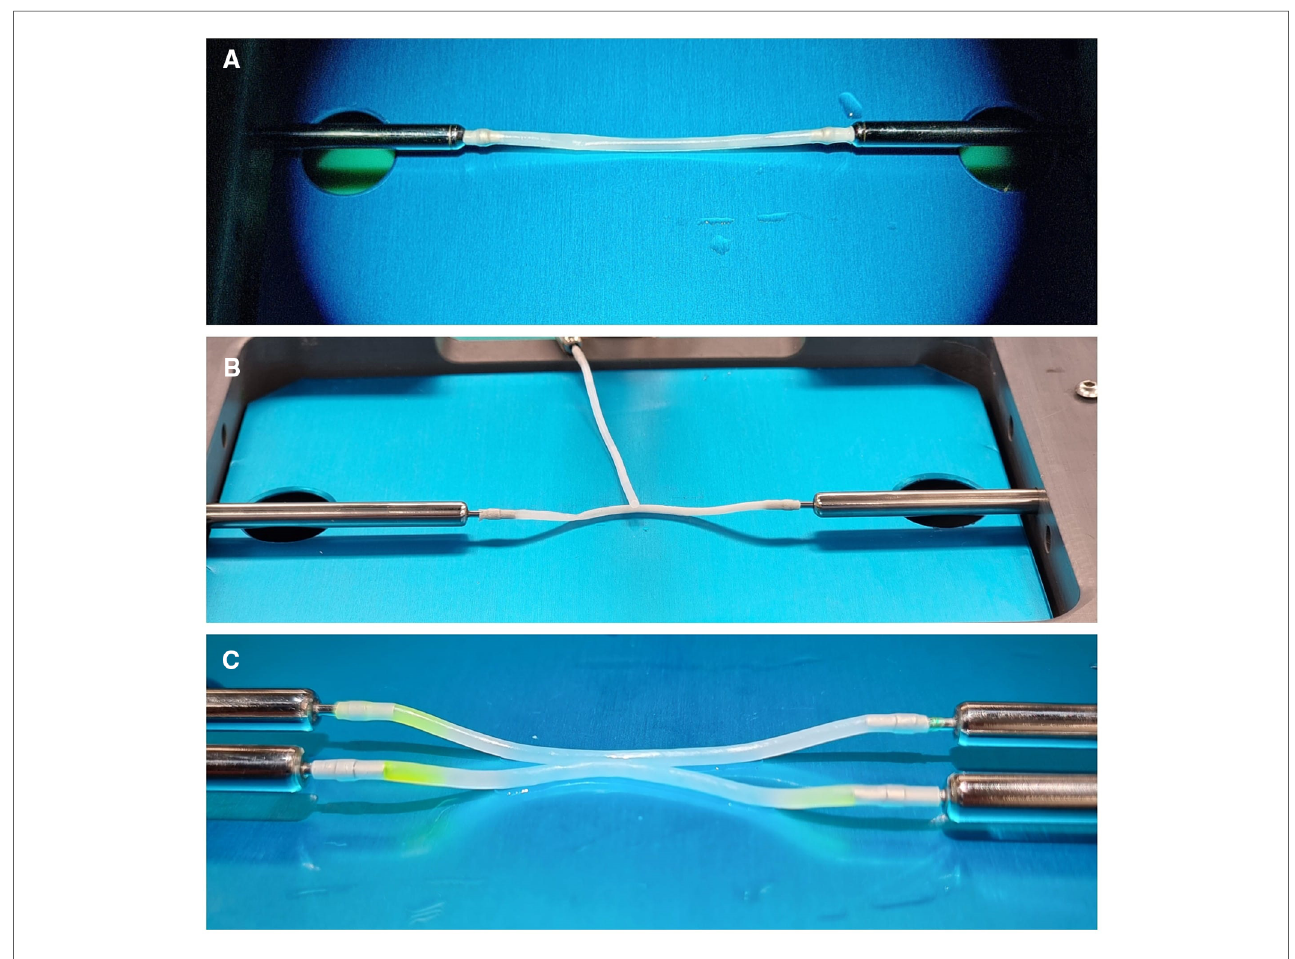
FIGURE 2 Details of Kezlez PVA hydrogel vessels. Setting for EE, ES and SS microanastomosis is shown in picture ( A – C )